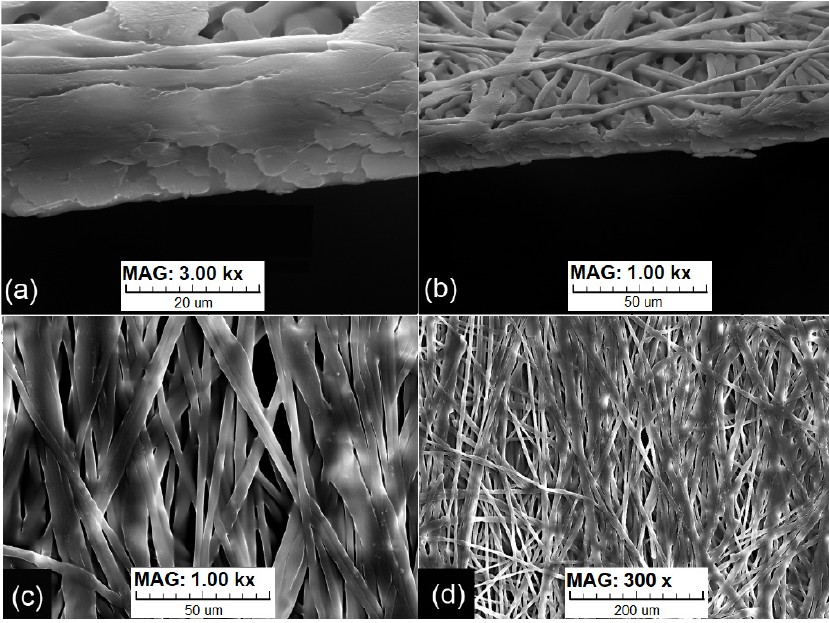
Figure 4. SEM images of composite PET/PUR membrane ( a , b ) cross-section ( c , d ) surface under 300×, 1000×, and 3000× magnifications.